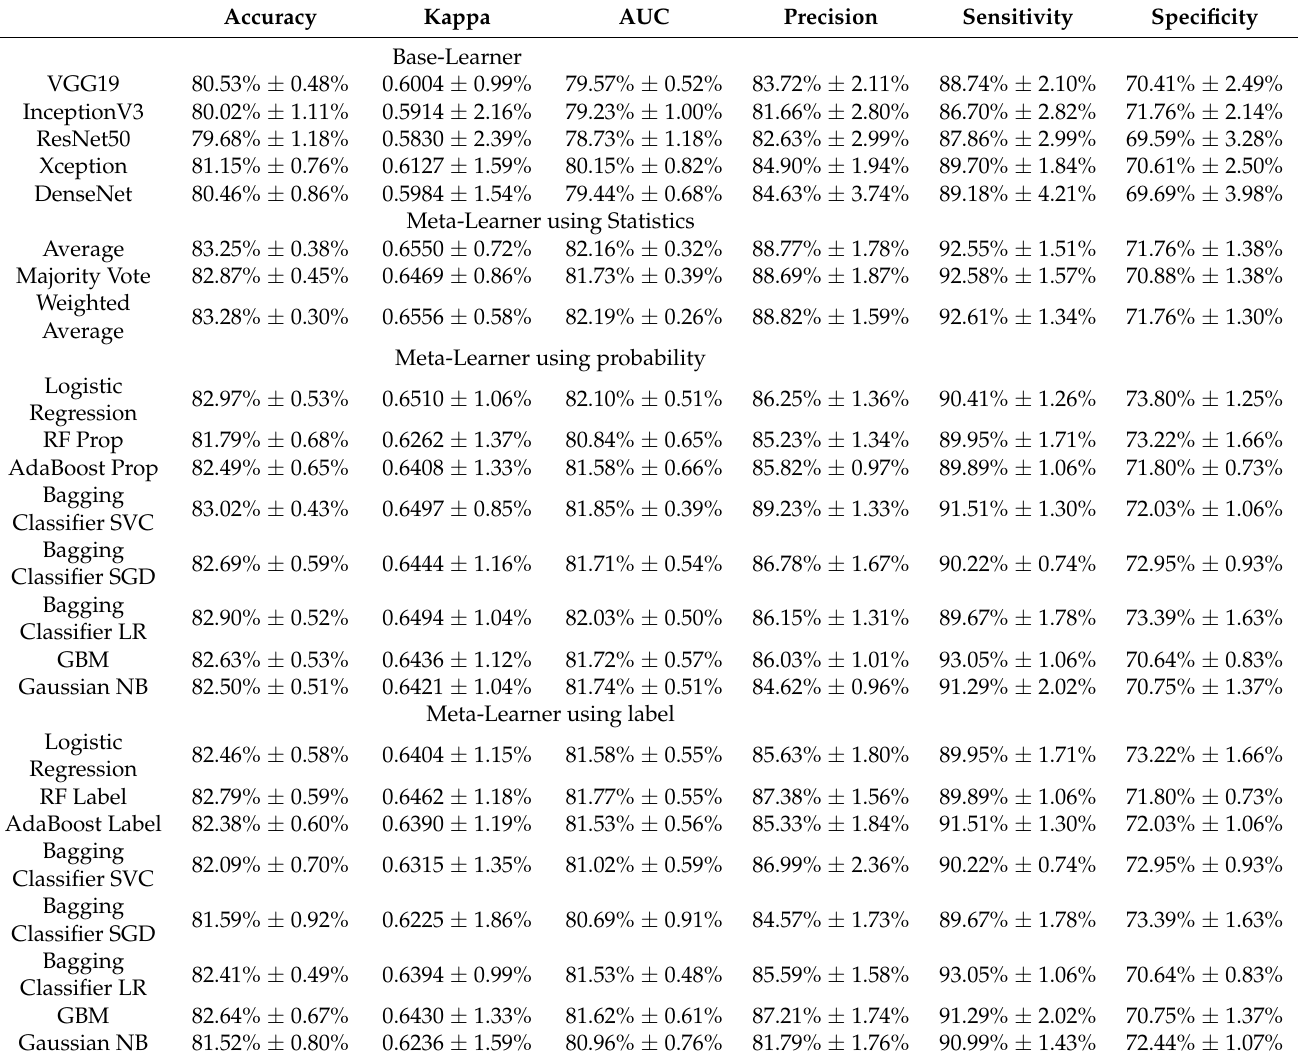
Table A4. The Kappa score achieved by each classifier for the wrist images ( ± Confidence Interval 95%). Test performance is